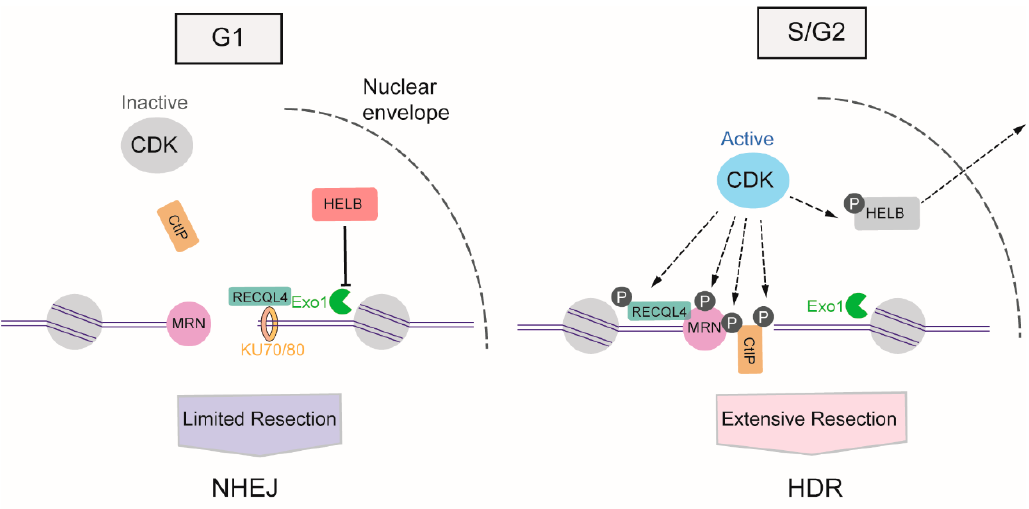
Figure 3. DNA resection-dependent regulation of DSB repair pathway choice by CDKs (cyclin-dependent kinases). CDKs activities arise from S phase and progresses in G2 and M phases, promoting the DNA resection through phosphorylation of multiple substrates, such as CtIP (C-terminal-binding protein interacting protein), MRN (MRE11-RAD50-NBS1)), HELB (helicase B), RECQL4 (ATP-dependent DNA helicase Q4) and Exo1 (exonuclease 1) .